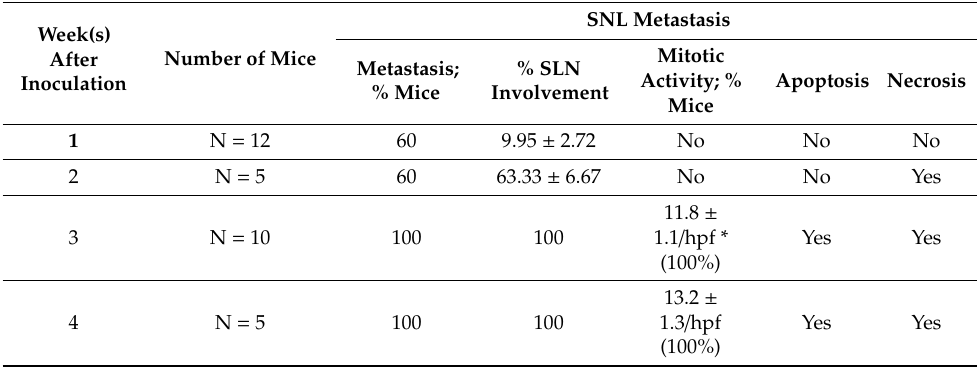
Figure 4. Metastatic disease in melanoma-bearing mice. ( a ) Percentage of mice with histologically detectable SLN and distant metastasis; inset: intravital photos of intact (left) and metastatic (right; week 2 after inoculation) cervical lymph node. ( b ) Histology and immunohistochemistry of organs from mice bearing ear melanoma. Table 1. Histological detection of SLN